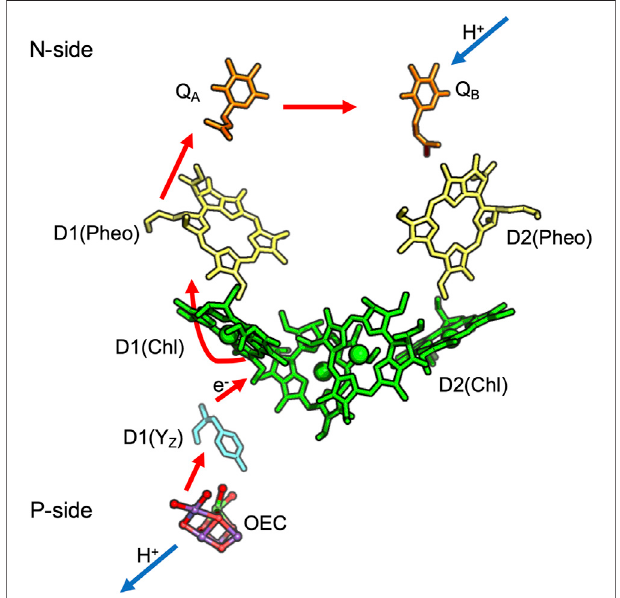
FIGURE 3 | Cofactors in PSII: Q A, Q B are plastoquinones, Pheo is Pheophytin; Chl is Chlorophyll. D1 and D2 are the protein subunit that binds each cofactor. Red arrows show electron transfer from theOEC to Q A and Q B while blue lines show proton uptake from the stroma to Q B and release from the OEC to the lumen. The coordinates for cyanobacteria Thermosynechococcus vulcanus are obtained from PDB ID: